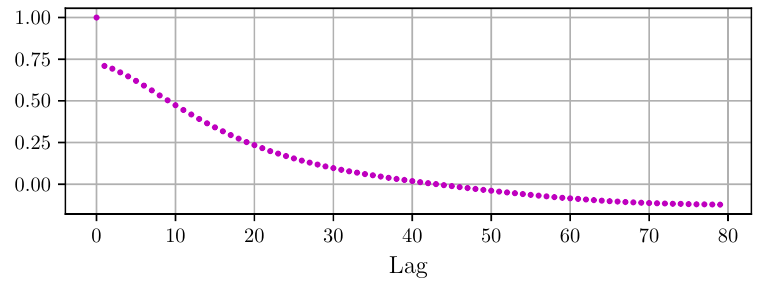
Figure 10. Normalized average autocorrelation function estimated from the residuals of the fitted photon